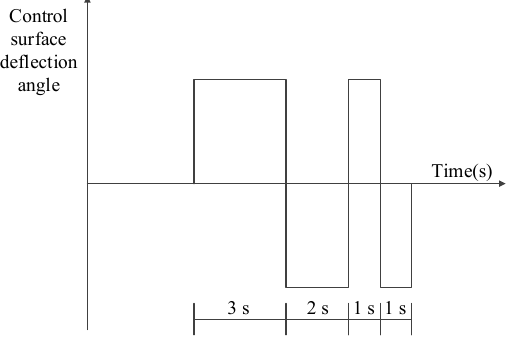
Figure 1. 3-2-1-1 input signal.